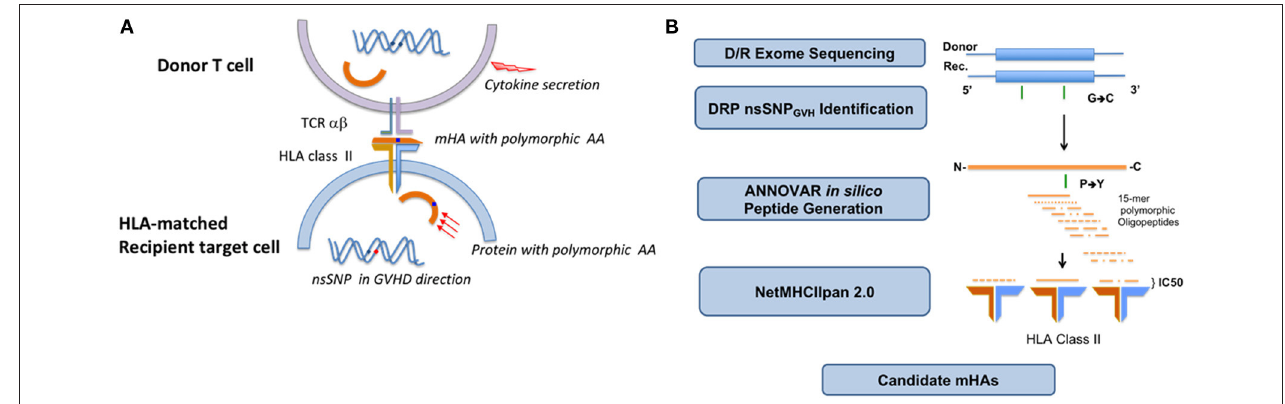
FIGURE 1 | Non-synonymous single nucleotide polymorphisms present in the recipient and absent in the donor yield alloreactive peptides which may be presented to the donor T cells on HLA class I and II molecules. HLA class II presentation and CD4 + T cell recognition and response depicted (A) . Schematic depicting the analytic sequence from exome sequencing to HLA class II mHA prediction (B)